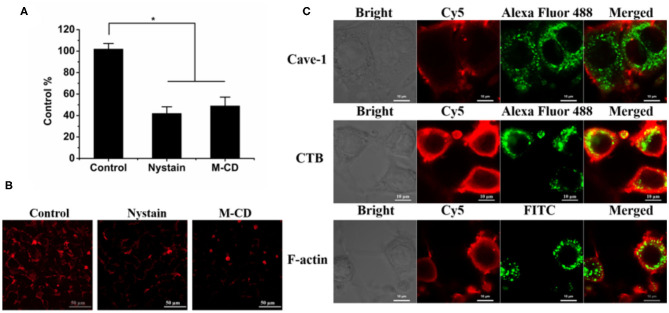
Internalization pathway. (A,B) Cellular uptake of Cy5-labeled BNRs in RAW 264.7 cells pre-treated with different inhibitors for 0.5 h was determined by (A) flow cytometry (mean ± SD, n = 3, *P < 0.01) and (B) CLSM observation after a 4 h incubation at 37°C (Scale bar, 50 μm). (C) Colocalization of Cy5-labeled BNRs with caveolae-trafficking proteins, Alexa Fluor 488-labeled CTB (green), Alexa Fluor 488-labeled Cave-1 (green), and FITC-labeled F-actin (green). The scale bar is 10 μm.